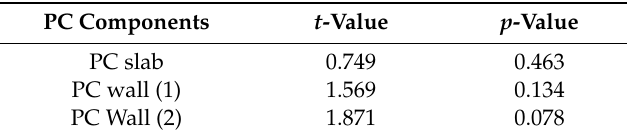
Figure 23. ( a ) The strain level results of lifting point 1 on a PC wall panel obtained from FEA analysis and sensor monitoring; ( b ) The strain level results of lifting point 2 on a PC wall panel obtained from FEA analysis and sensor monitoring. Table 4. The t-test results of the strain values.